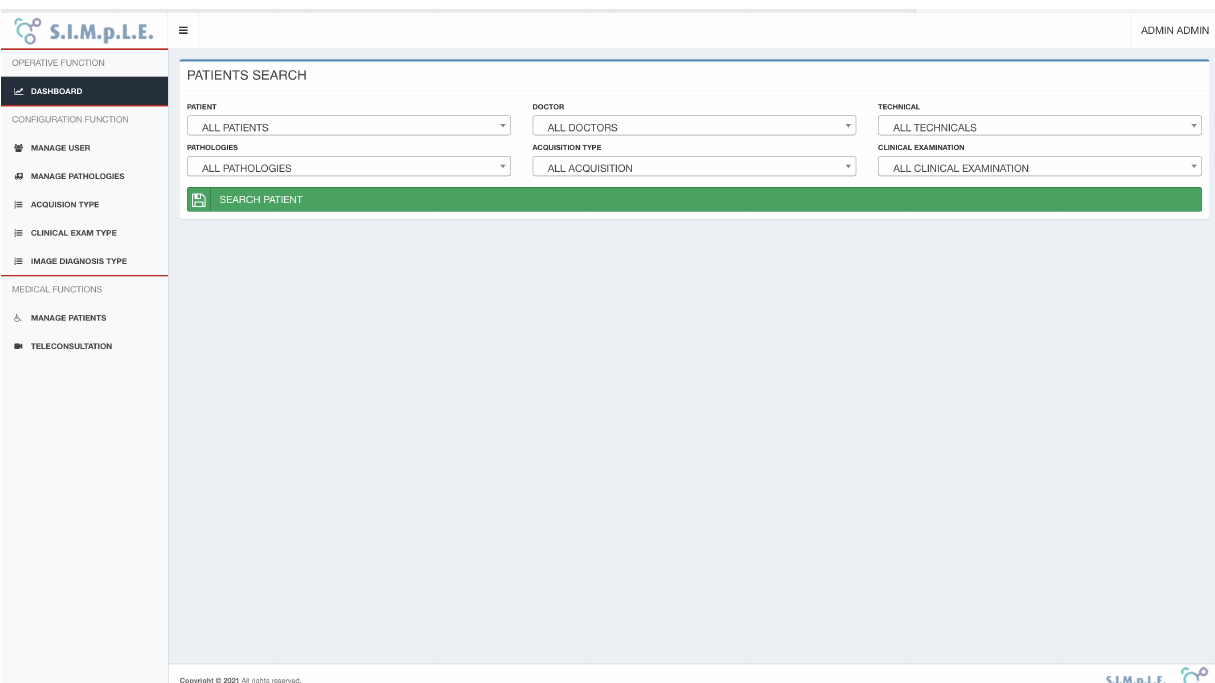
Figure 7. SIMpLE operational